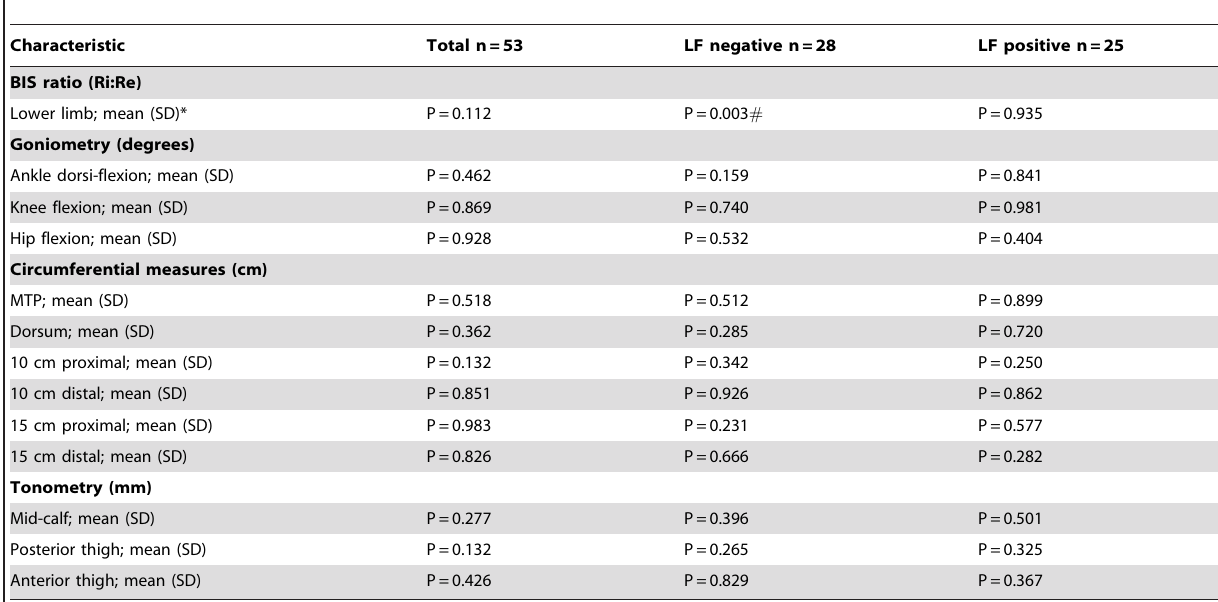
Table 3. Bioimpedance, range of motion, circumferential and tonometry measures comparing dominant with non-dominant limbs.